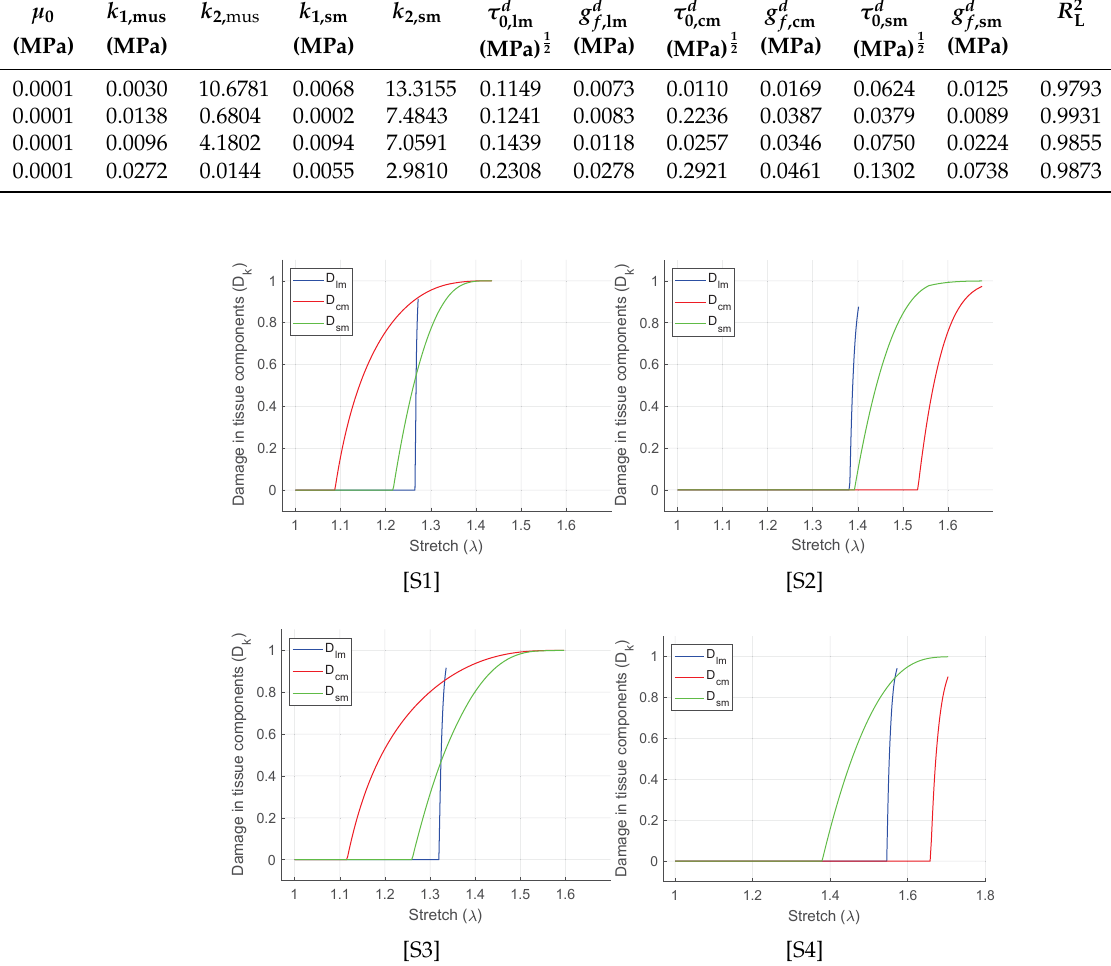
Figure 6. Evolution of damage in each layers D lm , D cm and D sm for the curve fit as shown in Figure